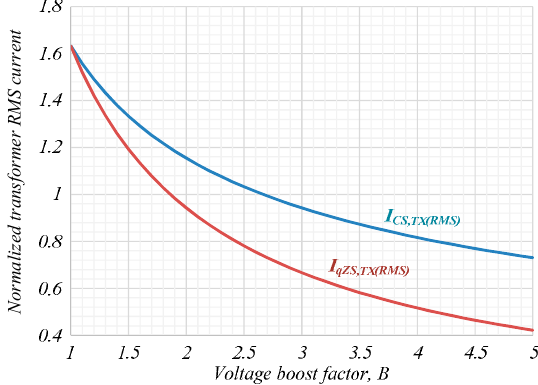
Figure 12. Normalized RMS current of the transformer input winding as a function of the input voltage boost factor B .